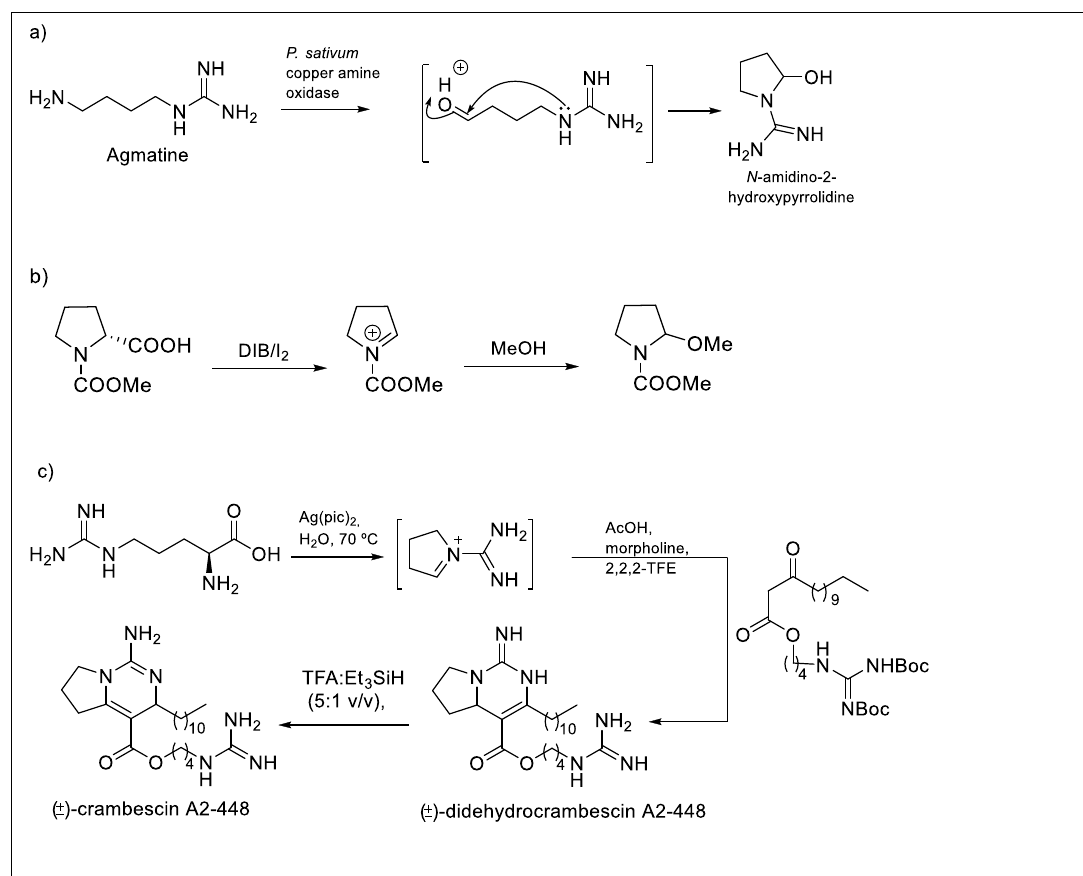
Figure 2. Reported efforts on the synthesis of a cyclic-guanidine core. Works from: a ) Ascenzi, P., et al.[24], b ) Boto, A., et al. [25,27], and c ) Silva et al [29].